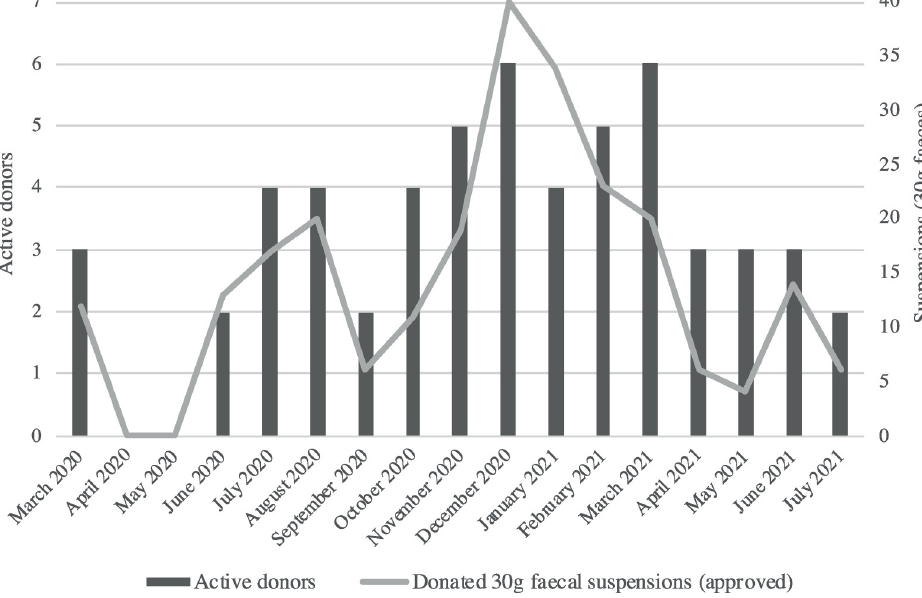
Fig 1. Faeces donations by donors active during the COVID-19 pandemic. The number of active NDFB donors per month, combined with the number of approved 30g faecal suspensions donated per month in the period from